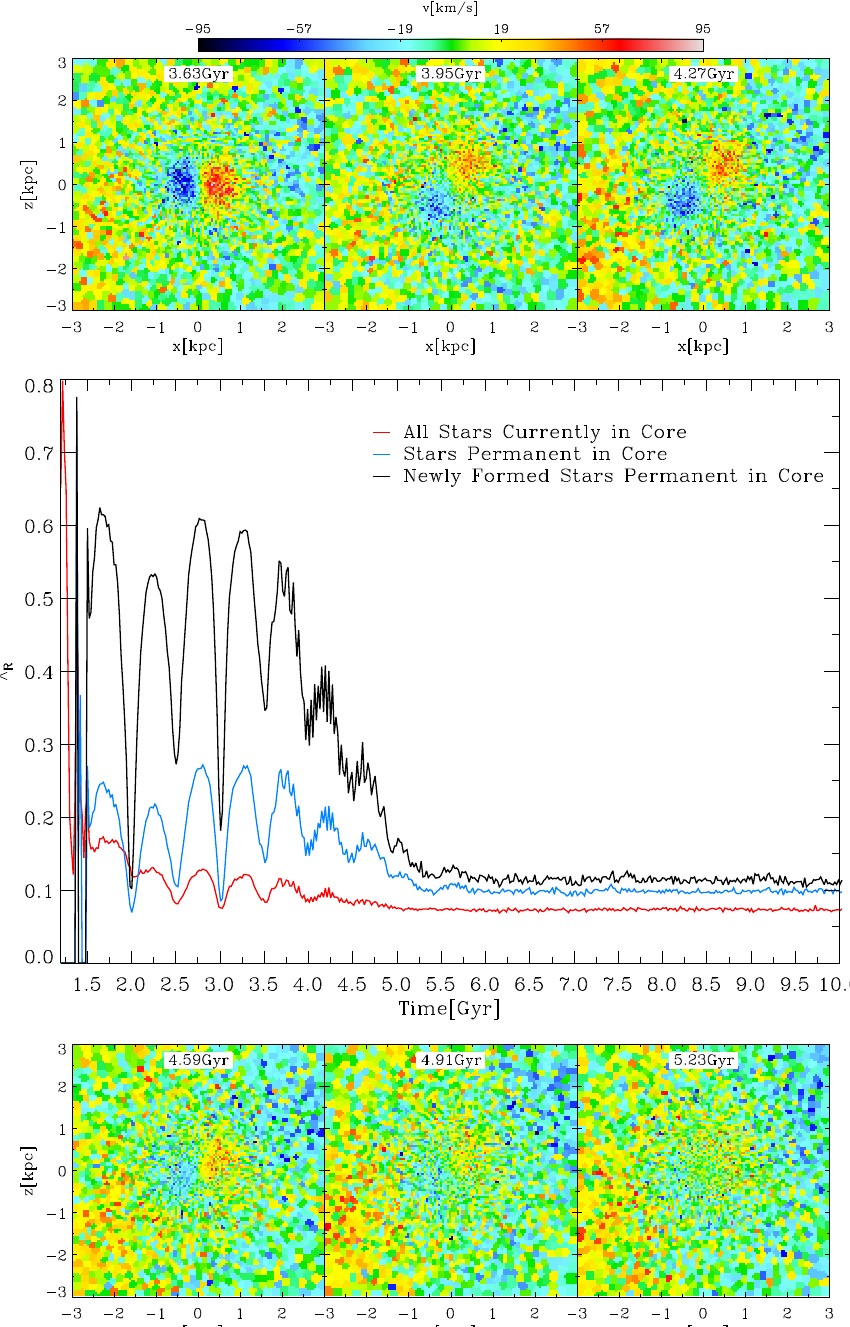
Figure 7. The upper and lower rows display a temporal sequence of the LOSVD maps of the central 3 kpc in the x – z projection visualising the gradual fade of the KDC. The main panel shows the temporal evolution of λ R in the x – z projection split up into three stellar populations: All stars that reside inside the core at a given time are represented by the red curve, while the blue and black curve trace the evolution for the permanent core stars and the newly formed permanent core stars,